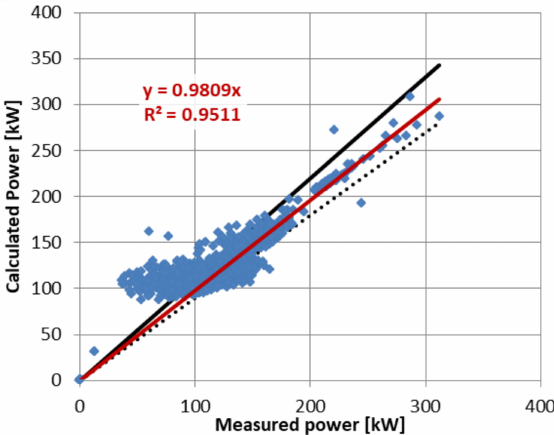
Figure A1. Result of model calibration with dataset CT1-Cal1, measured vs. calculated thermal power of cooling tower (41.2% outside +/ − 10% boundary); black solid/dotted lines show +/ − 10% boundaries.